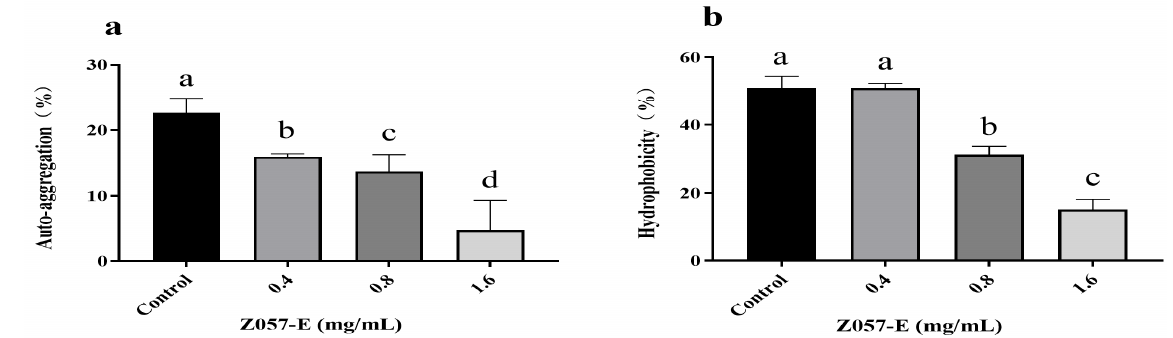
Figure 3. The effects of Z057-E on the auto-aggregation ( a ) and cell surface hydrophobicity ( b ) of V. parahaemolyticus . Significant differences ( p < 0.05) are indicated by different letters (a, b, c, and d).